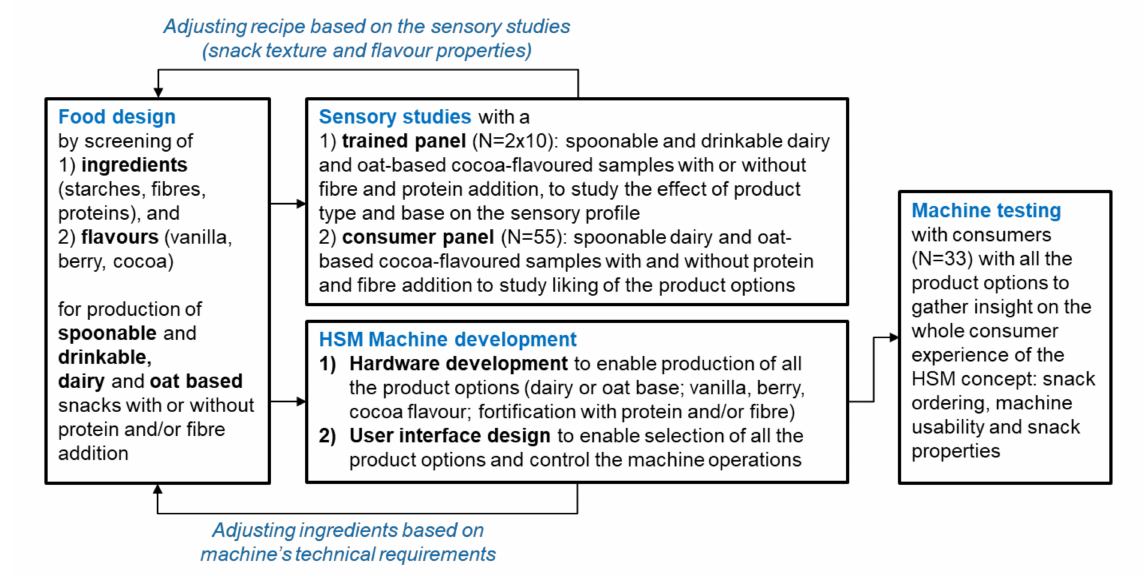
Figure 1. Scheme of the experimental